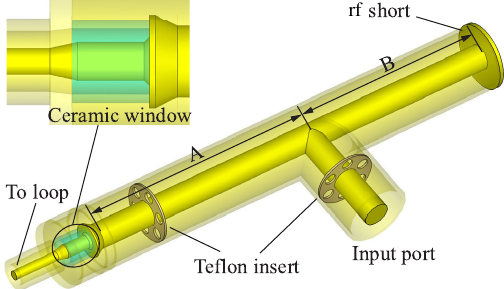
FIG. 33. The rf structure of the coupler with a matching port.